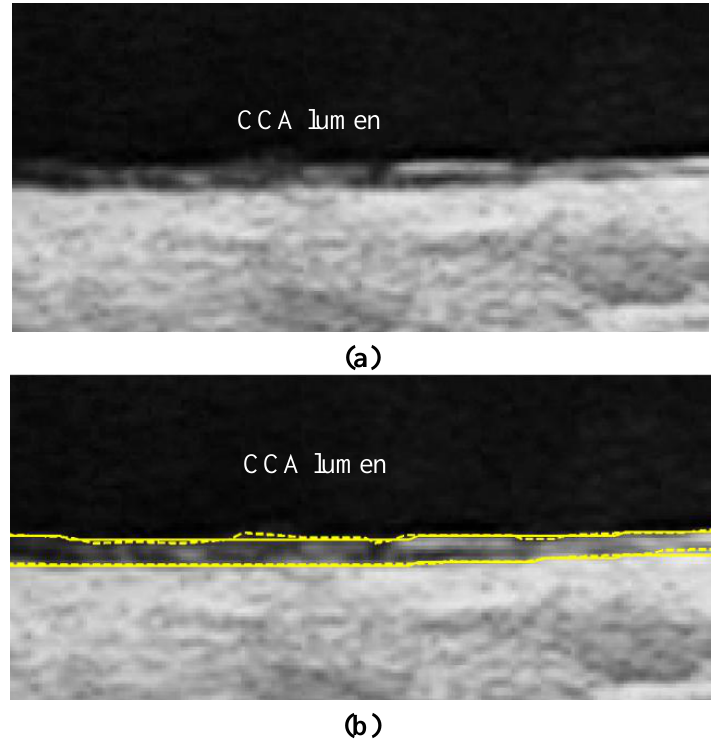
Figure 7. Far wall IMT detection. (a) Raw sub-image. (b) Solid line: Automatic detection result. Dash line: Manual drawing. (Sequence S2).